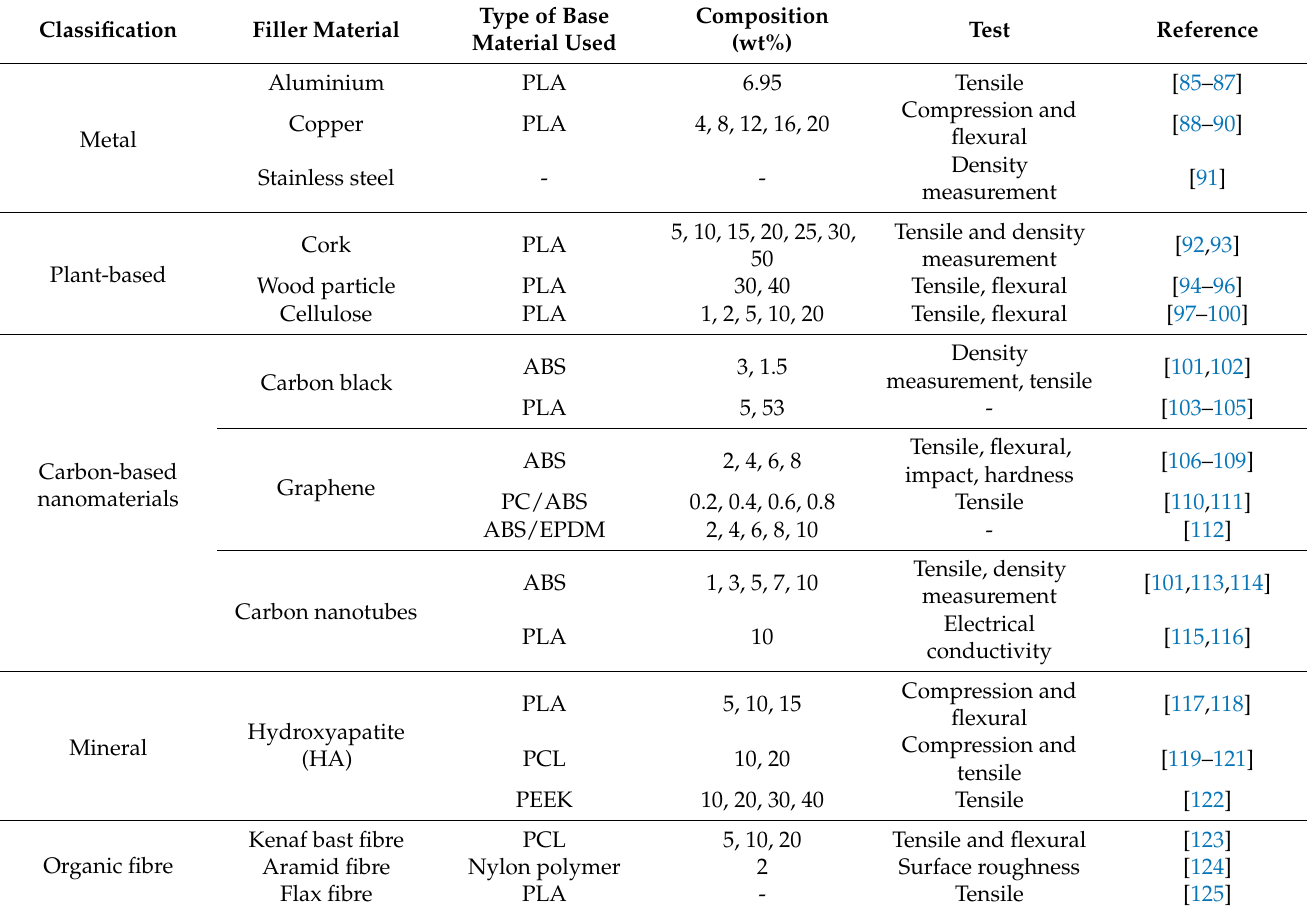
Figure 6. Materials that are used as filler to enhance properties of polymer. Table 2. Classification of filler material and the conducted test.